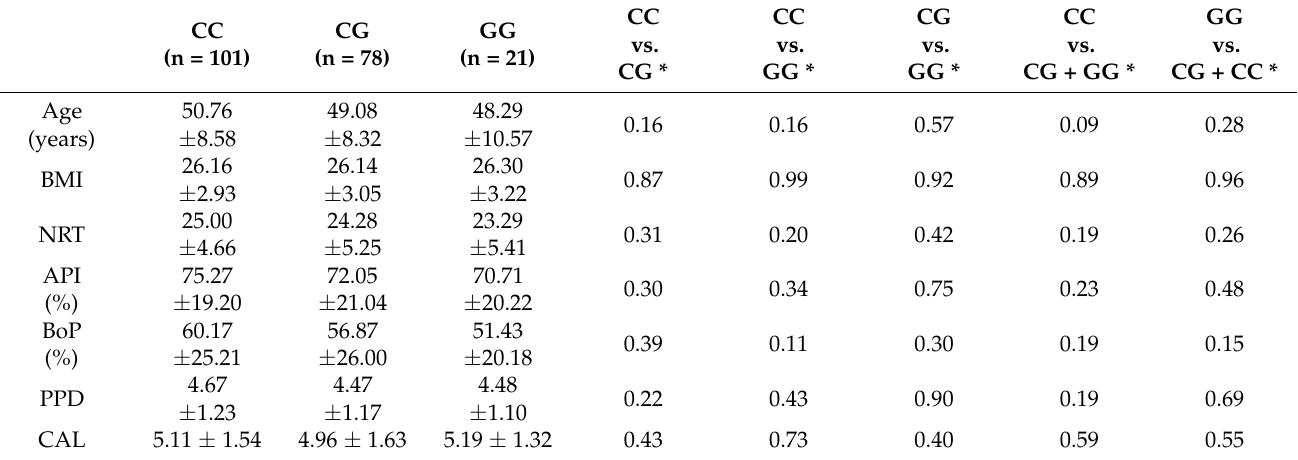
Table 5. The associations between the selected baseline clinical parameters (mean values ± SD) and IL-18 rs187238